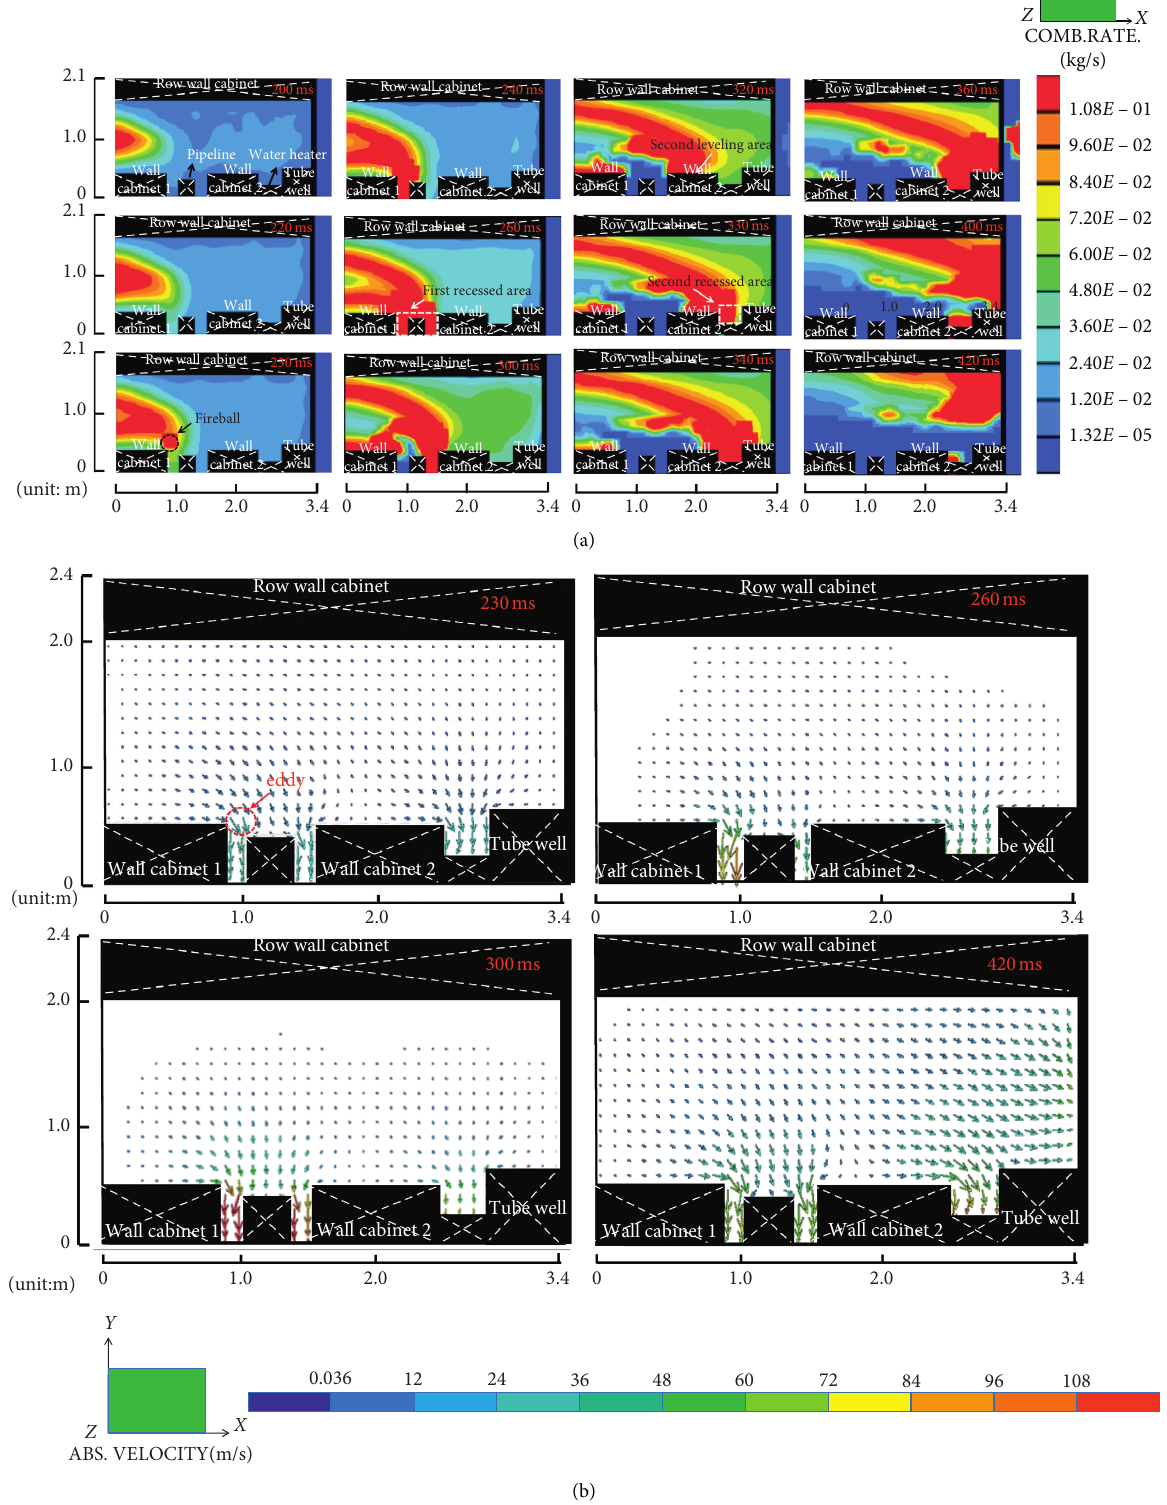
Figure 15: The variation law of (a) flame propagation and (b) flow-field velocity vector on the z � 2 m slice after